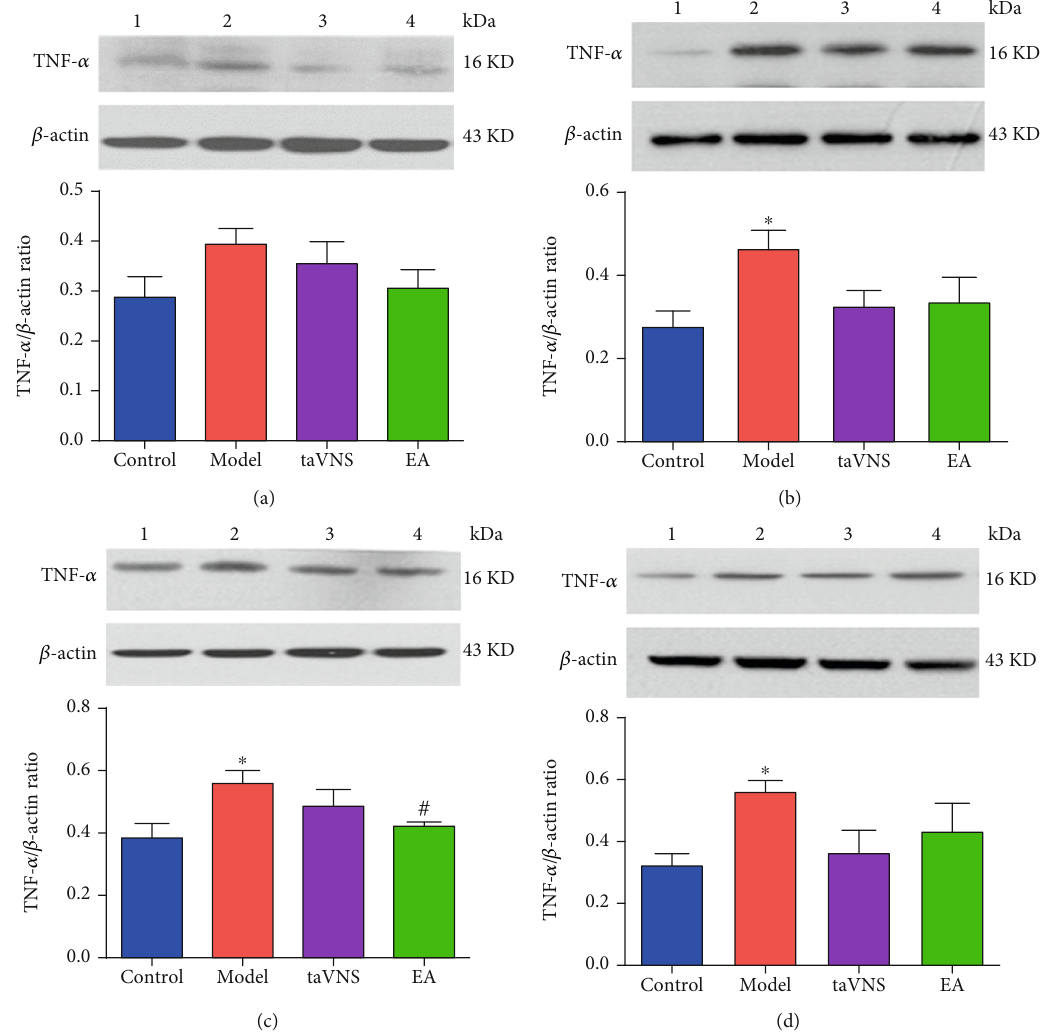
Figure 3: Expressions of TNF- α in PFC, hippocampus, amygdala, and hypothalamus. (a) Comparison of the TNF- α expression in the PFC for each group at 28 day. (b) Comparison of the TNF- α expression in the hippocampus for each group at 28 day. (c) Comparison of the TNF- α expression in the amygdala for each group at 28 day. (d) Comparison of TNF- α expression in the hypothalamus for each group at 28 day. 1: control group; 2: model group; 3: taVNS group; 4: EA group. ∗ P < 0 : 05 , vs. the control group. # P < 0 : 05 , vs. the model